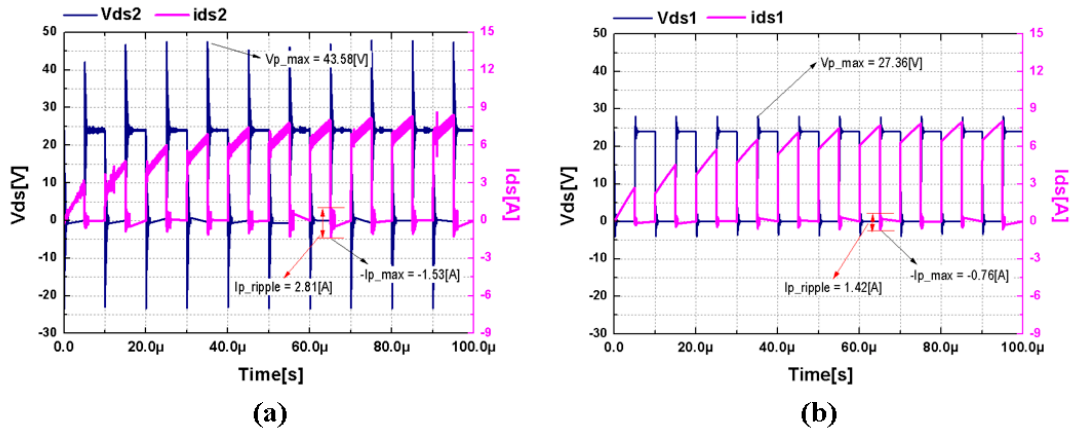
Figure 16. The switching waves of drain-source voltage and current in system. ( a ) The voltage and current switching waveforms before method applied; ( b ) The voltage and current switching waveforms after method applied.